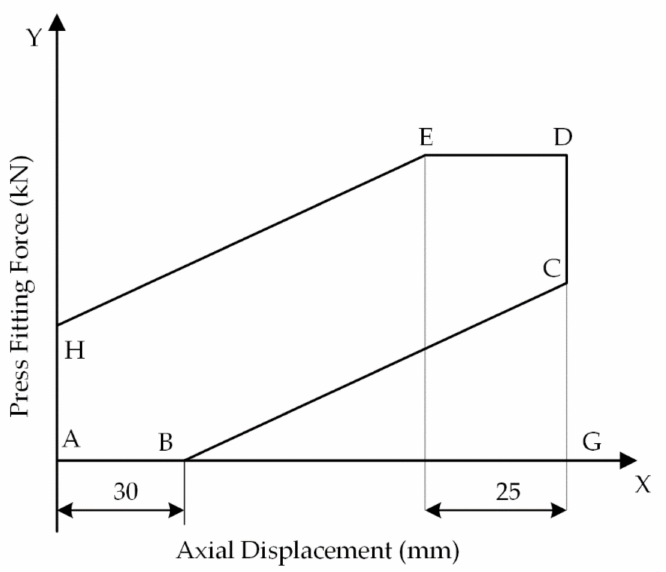
Figure 3. Press-fitting curve for a railway wheelset: force vs axial displacement